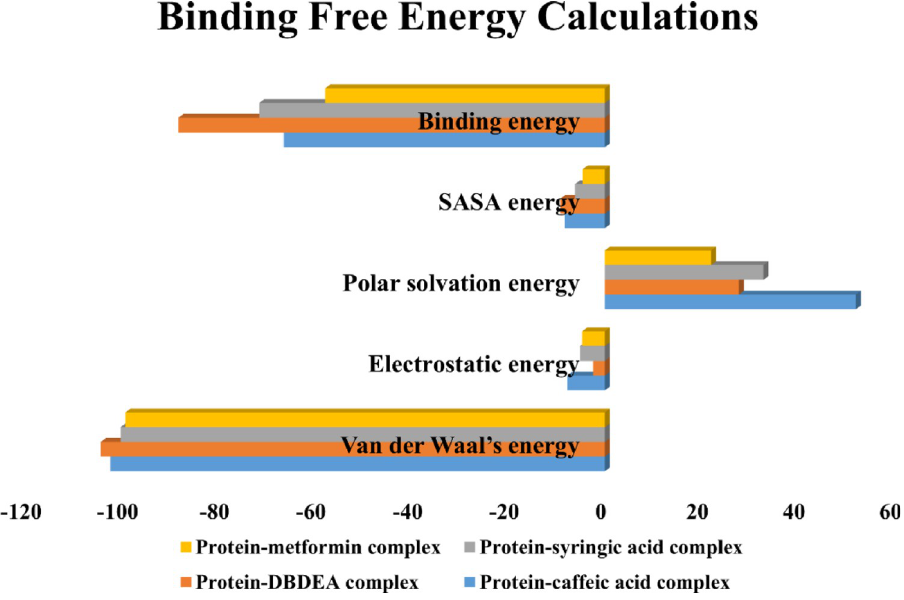
Fig 14. Graphical representation of binding free energies of protein-ligand